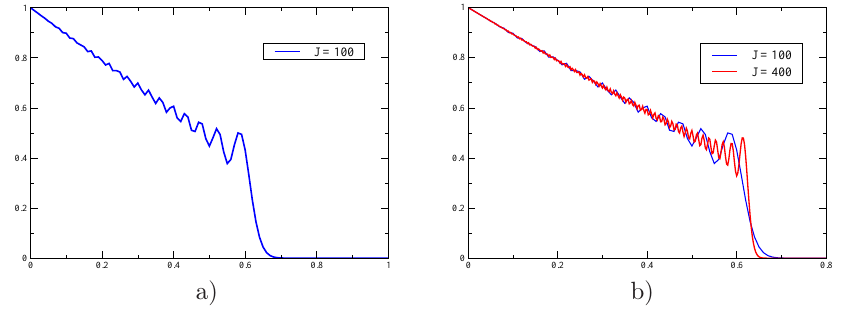
Figure 2. Solution of the hyperbolic heat conduction problem (5.1) at t f = 0 . 2 for: a) J = 100 , b) J = 400